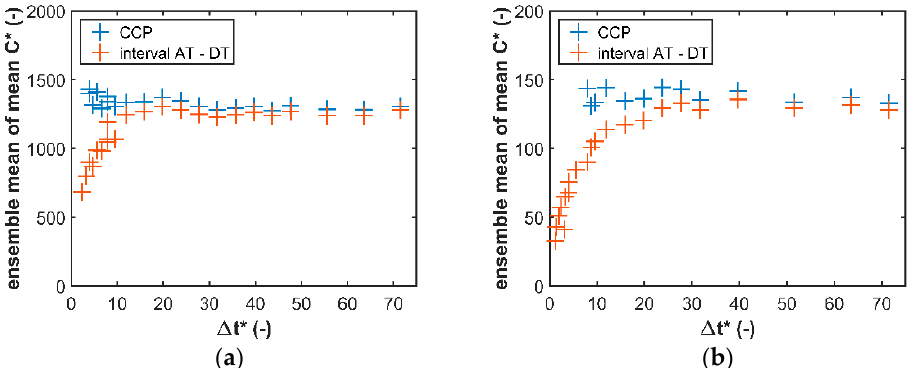
Figure 6. Comparison of the ensemble mean of CCP mean concentrations and the mean concentrations calculated from entire clouds (time interval arrival time (AT)–departure time (DT)) for: ( a ) position P; ( b ) position T.